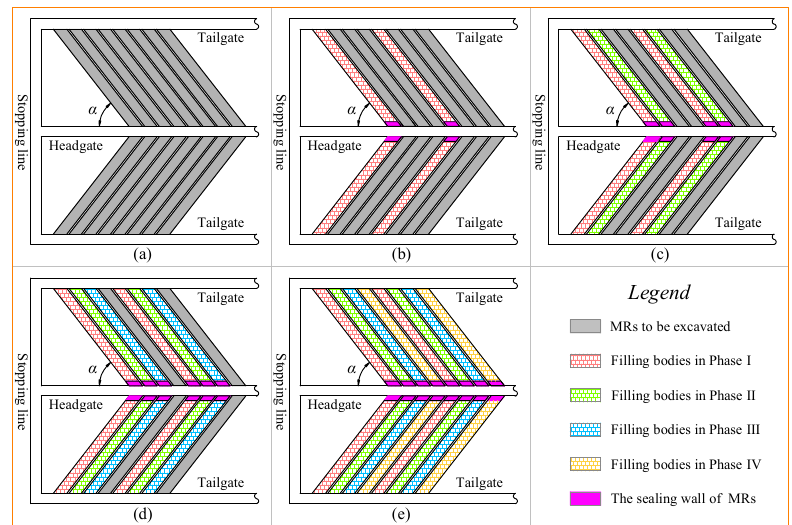
Figure 2. Schematic map of the processes of CECB. ( a ) The arrangement of MRs; ( b ) MRs of phase Ⅰ have been excavated and filled; ( c ) MRs of phase Ⅱ have been excavated and filled; ( d ) MRs of phase Ⅲ have been excavated and filled; ( e ) MRs of phase Ⅳ have been excavated and filled. Reprinted with permission from ref. [32]. Copyright 2019 MDPI.